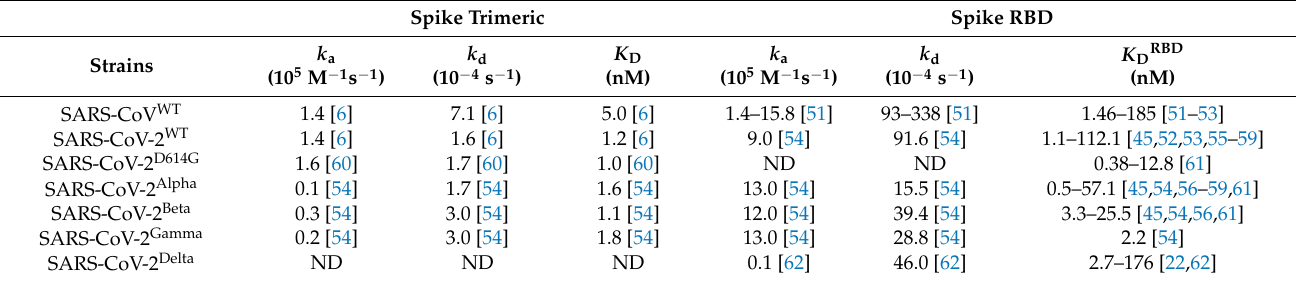
Table 1. Kinetic parameters of RBD-hACE2 complex formation. Equilibrium dissociation constants ( K D ) calculated for RBD and its variants in the complex with dimeric hACE2 protein. Experimental K D values were also measured using a trimeric Spike protein and its variants for interacting with